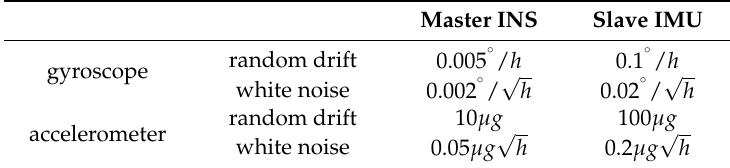
Table 1. The sensors’ specifications of master INS and slave IMUs.